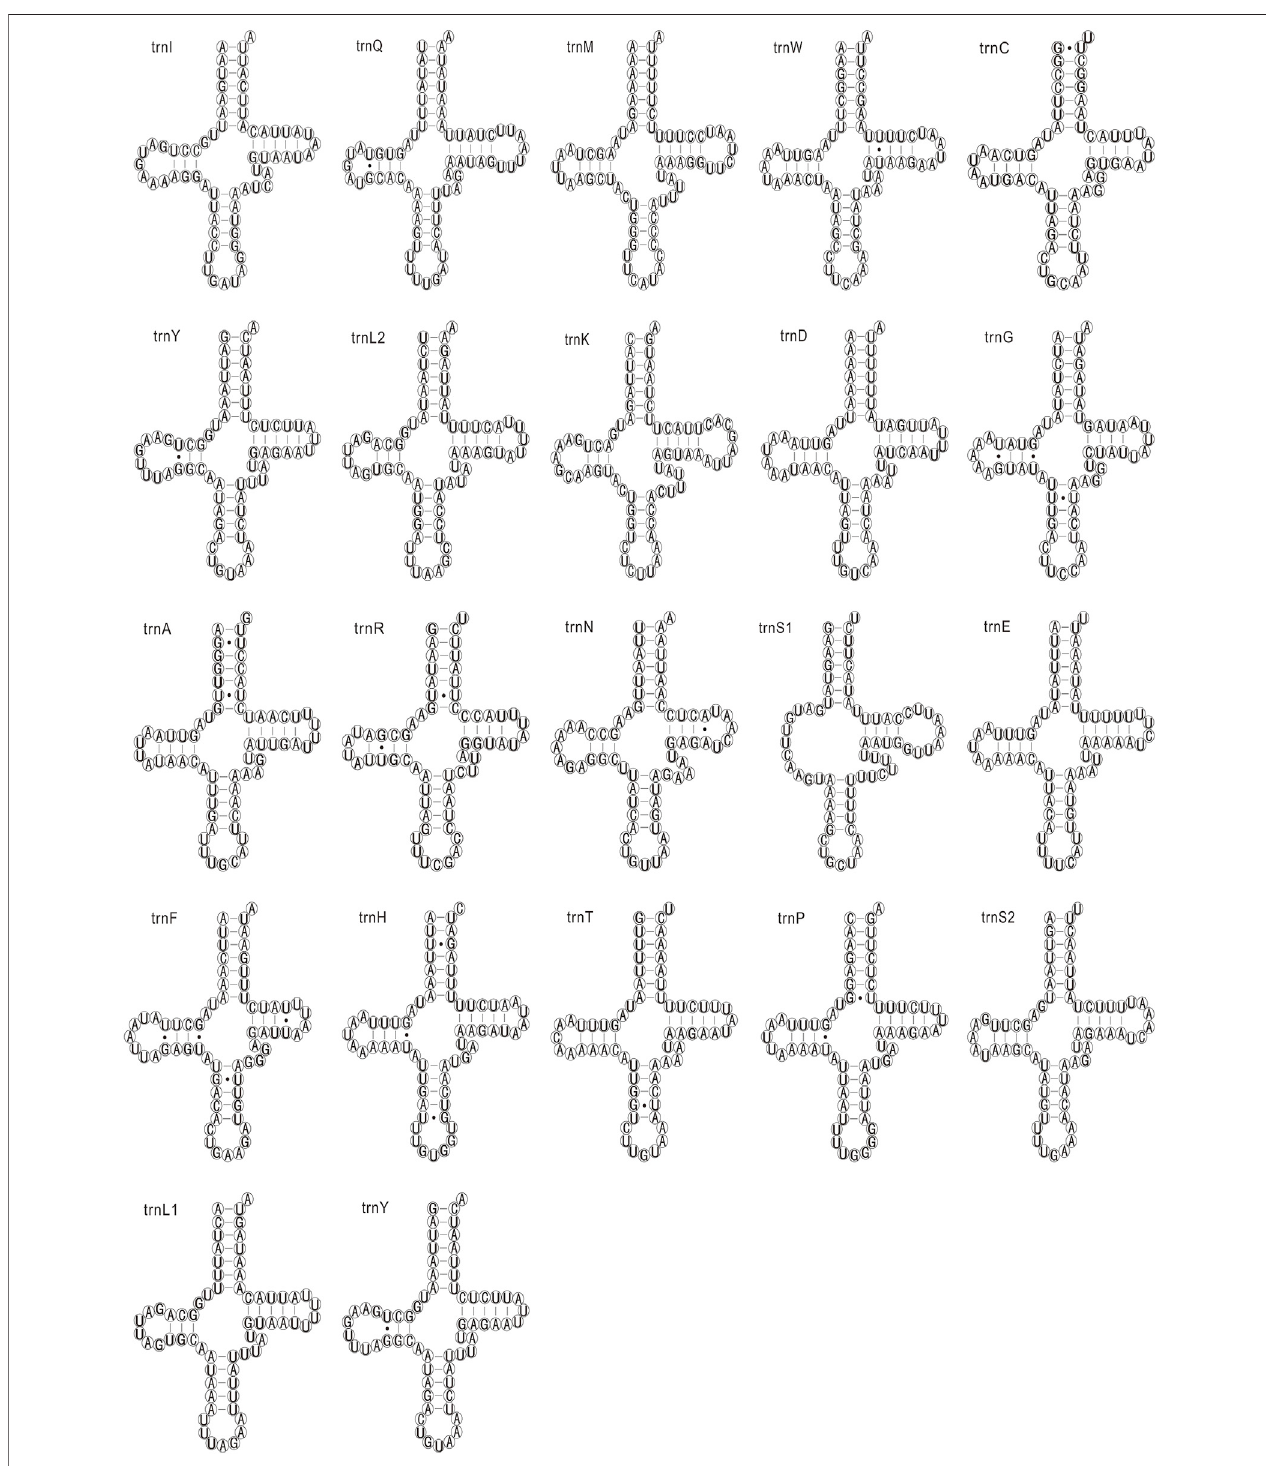
FIGURE3| InferredsecondarystructureoftransferRNAs(tRNAs)inthe Calliphoranigribarbis mitogenome.AlltRNAgenesareshownintheorderofoccurrencein the mitochondrial genome starting from trnI. tRNAs are labeled with the abbreviations. Dashes ( − ) indicate Watson – Crick base pairing.